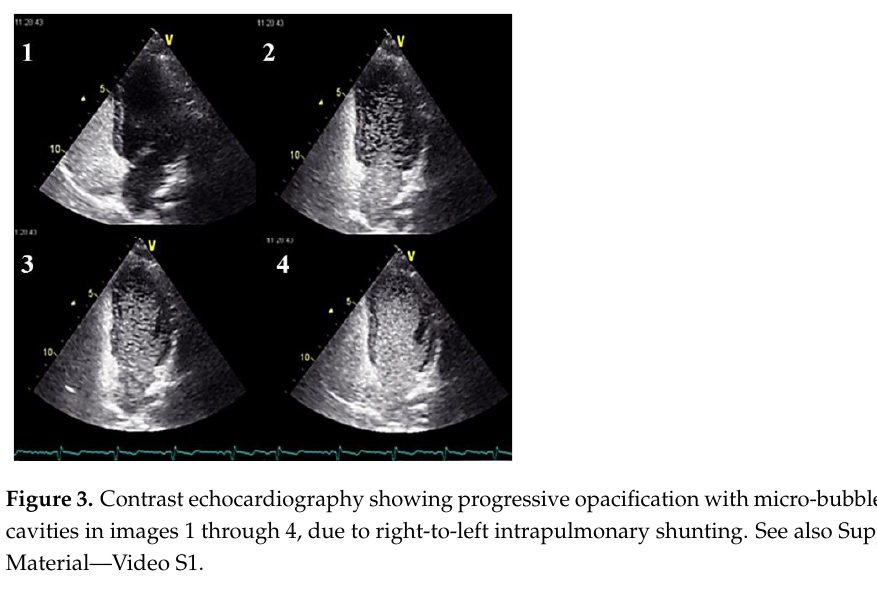
Figure 2. Chest computer tomography showing a pulmonary arterio-venous malformation (arrow).